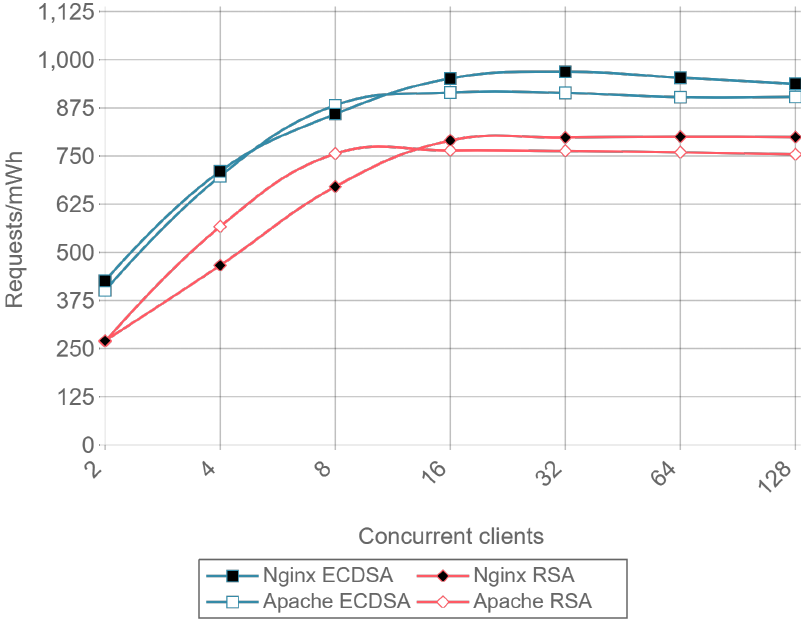
Figure 19. Client-side concurrent clients versus requests/mWh Apache2 and Nginx with 512 bytes of payload for Elliptic Curve Digital Signature Algorithm (ECDSA) and Rivest–Shamir–Adleman (RSA).